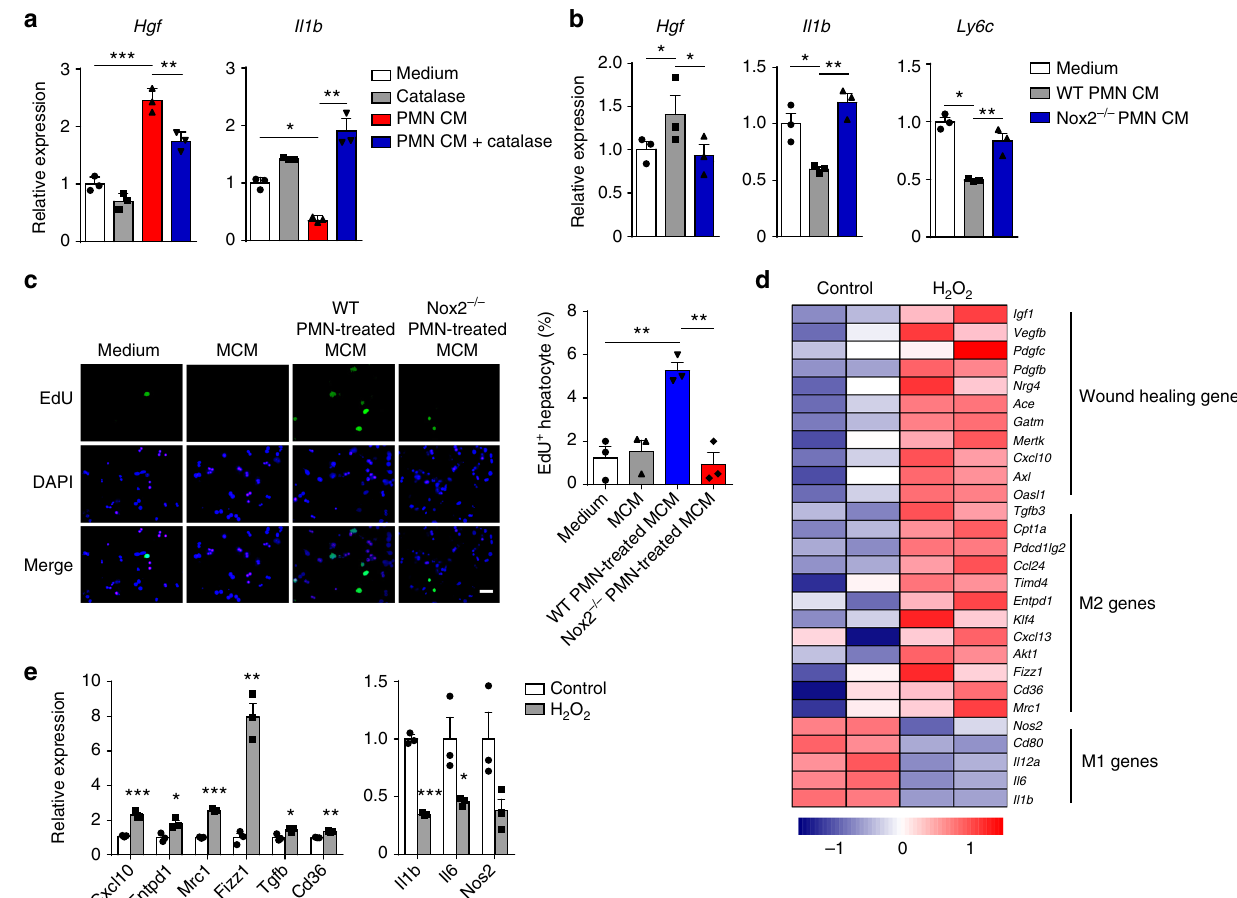
Fig. 5 ROS mediate phenotypic conversion of pro-in fl ammatory macrophages ex vivo. a The 24 h Ly6C hi CX 3 CR1 lo monocytes/macrophages were co- cultured with CM from 24 h neutrophils in the absence or presence of catalase for 6 h. The expression of the indicated genes was measured by qPCR. n = 3. Experiment was repeated twice. b The 24 h Ly6C hi CX 3 CR1 lo monocytes/macrophages were co-cultured with CM from 24 h WT or Nox2 − / − neutrophils for 6 h. The expression of the indicated genes was measured by qPCR. n = 3. Experiment was repeated twice. c Hepatocyte proliferation was induced by the CM from the 24 h Ly6C hi CX 3 CR1 lo monocytes/macrophages (MCM) that had been exposed to CM from 24 h WT or Nox2 − / − neutrophils. Representative images of hepatocytes pulsed with EdU (left panel) and the quanti fi cation of hepatocyte proliferation (right panel). Scale bar, 50 μ m. n = 3. Experiment was repeated twice. d Peritoneal macrophages were treated with LPS (100 ng ml − 1 ) for 3 h to polarize into pro-in fl ammatory phenotype and then were stimulated with 20 μ M H 2 O 2 for 4 h. Heatmap showing differential expression of the indicated genes in H 2 O 2 -treated macrophages as compared to control macrophages. Row-based Z -score normalized. e Expression of the indicated genes in H 2 O 2 -treated or untreated macrophages were determined by qPCR. n = 3. Experiment was repeated twice. The results represent mean ± s.e.m. (* P < 0.05, ** P < 0.01, *** P < 0.001). P values were calculated by